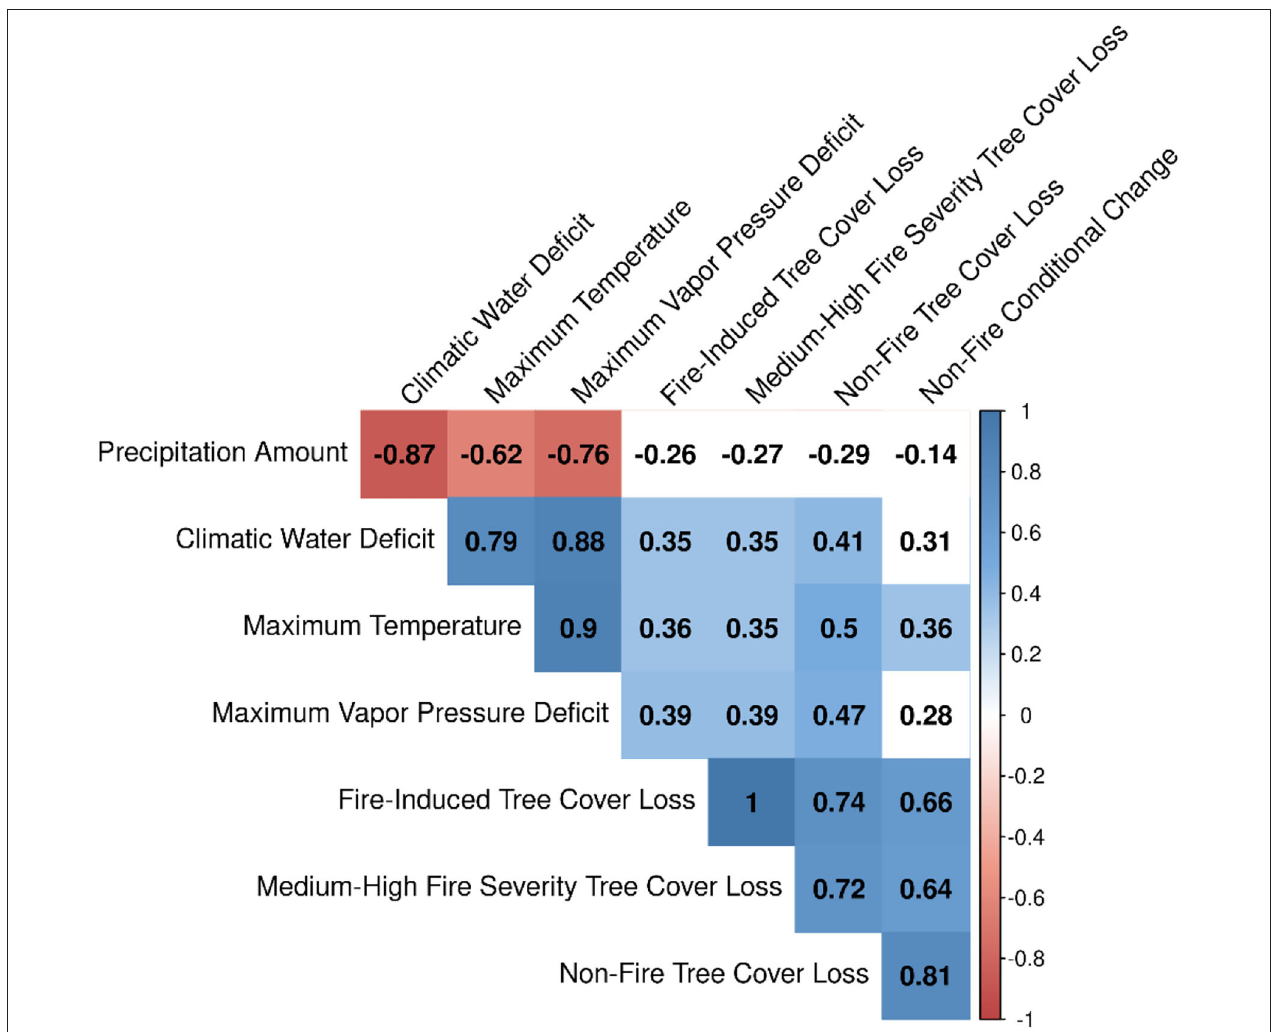
FIGURE 6 | Correlation matrix showing associations among annual area of tree cover change and climate anomalies for the period 1985–2016. Correlations were significant at p -values < 0.05. Relationships that are non-significant are colored in white.